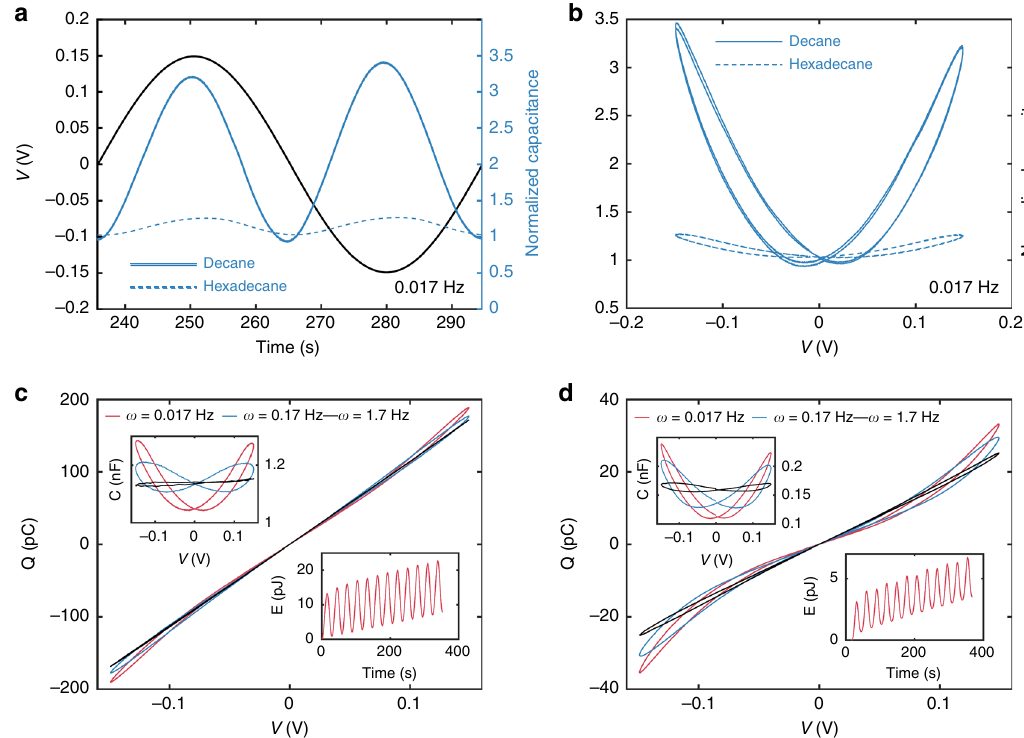
Fig. 3 Frequency dependence of pinched hysteresis for DPhPC memcapacitors. a , b Display the dynamical capacitance of a symmetric DPhPC bilayer as a function of time and voltage, respectively. The results show that steady-state dynamic capacitance is minimum when v is zero. As expected, EW and EC incur signi fi cantly greater changes in normalized capacitance ( C / C 0 ) for a DPhPC bilayer in decane. c , d Display Q - v and C - v (upper insets) measured in response to a sinusoidal voltage, v ( t ), applied to DPhPC bilayer memcapacitors assembled in hexadecane and decane, respectively. The lower insets in each display the energy dissipated by the recon fi gurable membrane at an excitation frequency of 0.017 Hz. Pinched hysteresis for bilayers in hexadecane occurs at excitation frequencies between 0.005 – 2 Hz, whereas bilayers in decane exhibit pinched hysteresis across a wider frequency range, from 0.001 – 5 Hz. These results highlight the system ’ s modularity, where changing the oil can be used to tune the bandwidth of memory